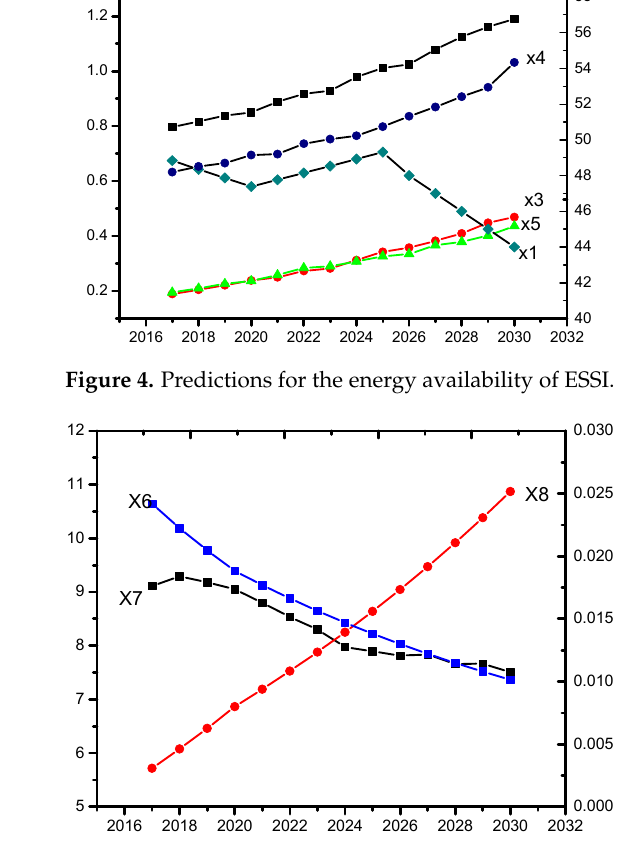
Figure 5. Predictions for the economic sustainability of ESSI.